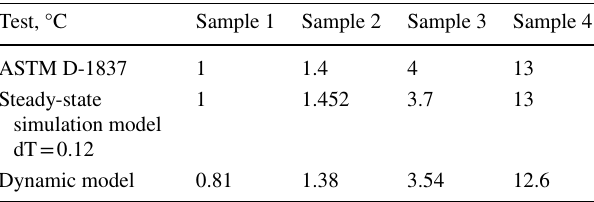
Table 7 LPG residue by steady-state and dynamic models compared with the residue of LPG by ASTM D1837 test